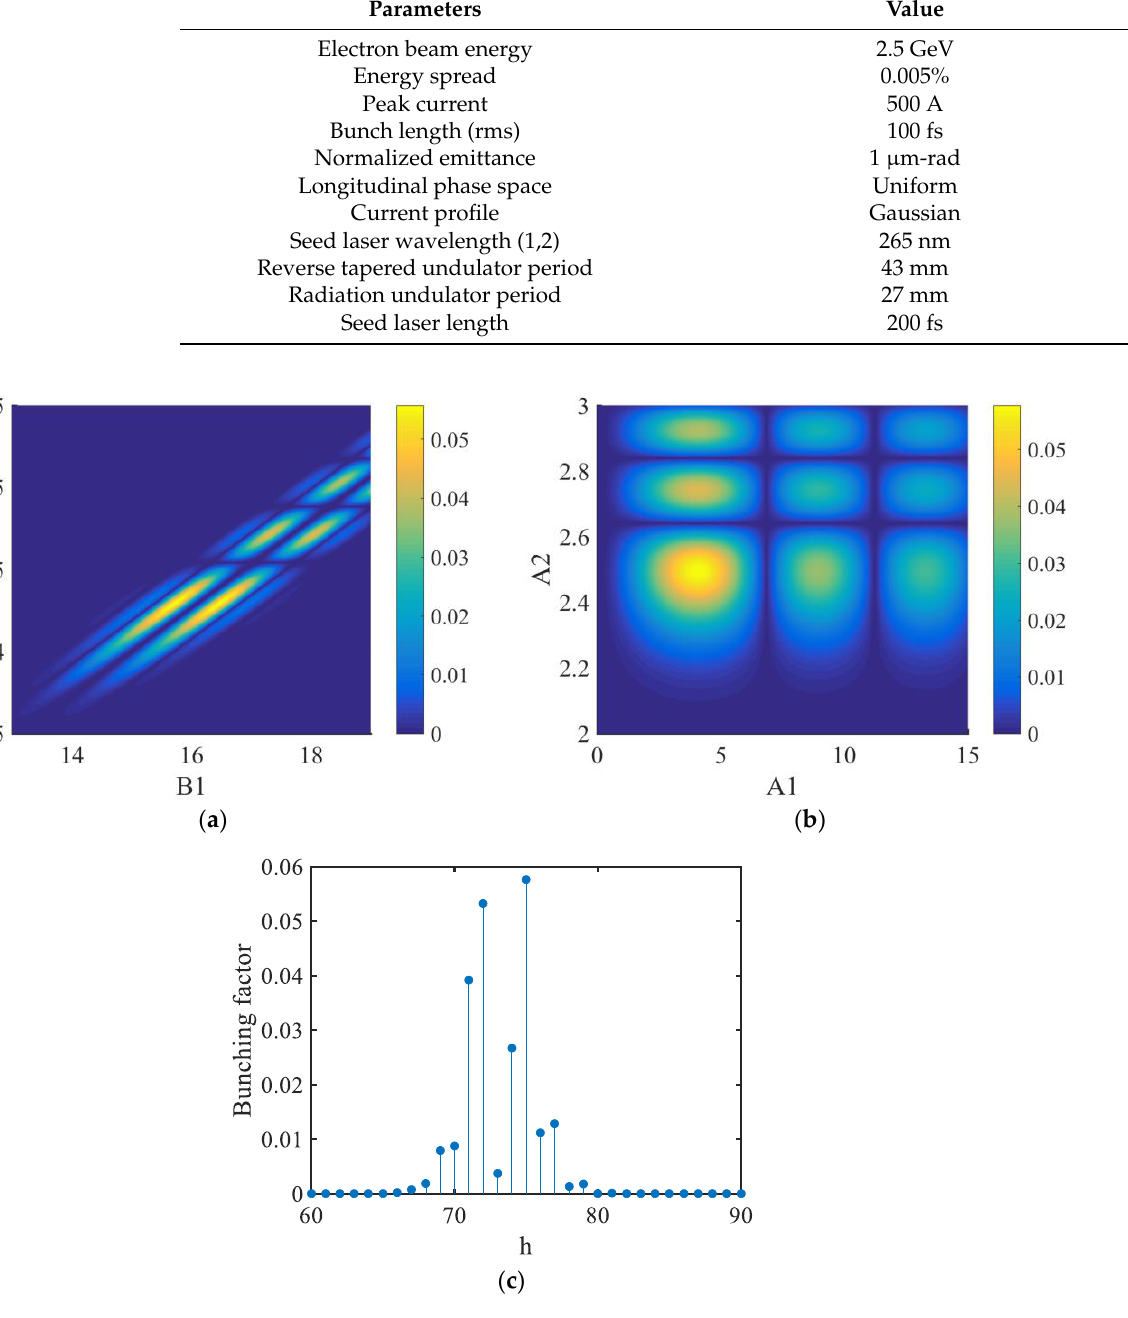
Figure 2. ( a ) The calculated bunching factor at 75th harmonic 𝑏 75 as a function of 𝐵 1 , 𝐵 2 ( 𝐴 1 = 3.5, 𝐴 2 = 2 ); ( b ) The calculated bunching factor at 75th harmonic 𝑏 75 as a function of 𝐴 1 , 𝐴 2 (B1 = 15.75, 𝐵 1 = 0.43 ); ( c ) The relation between the calculated bunching factors and harmonic numbers ℎ .